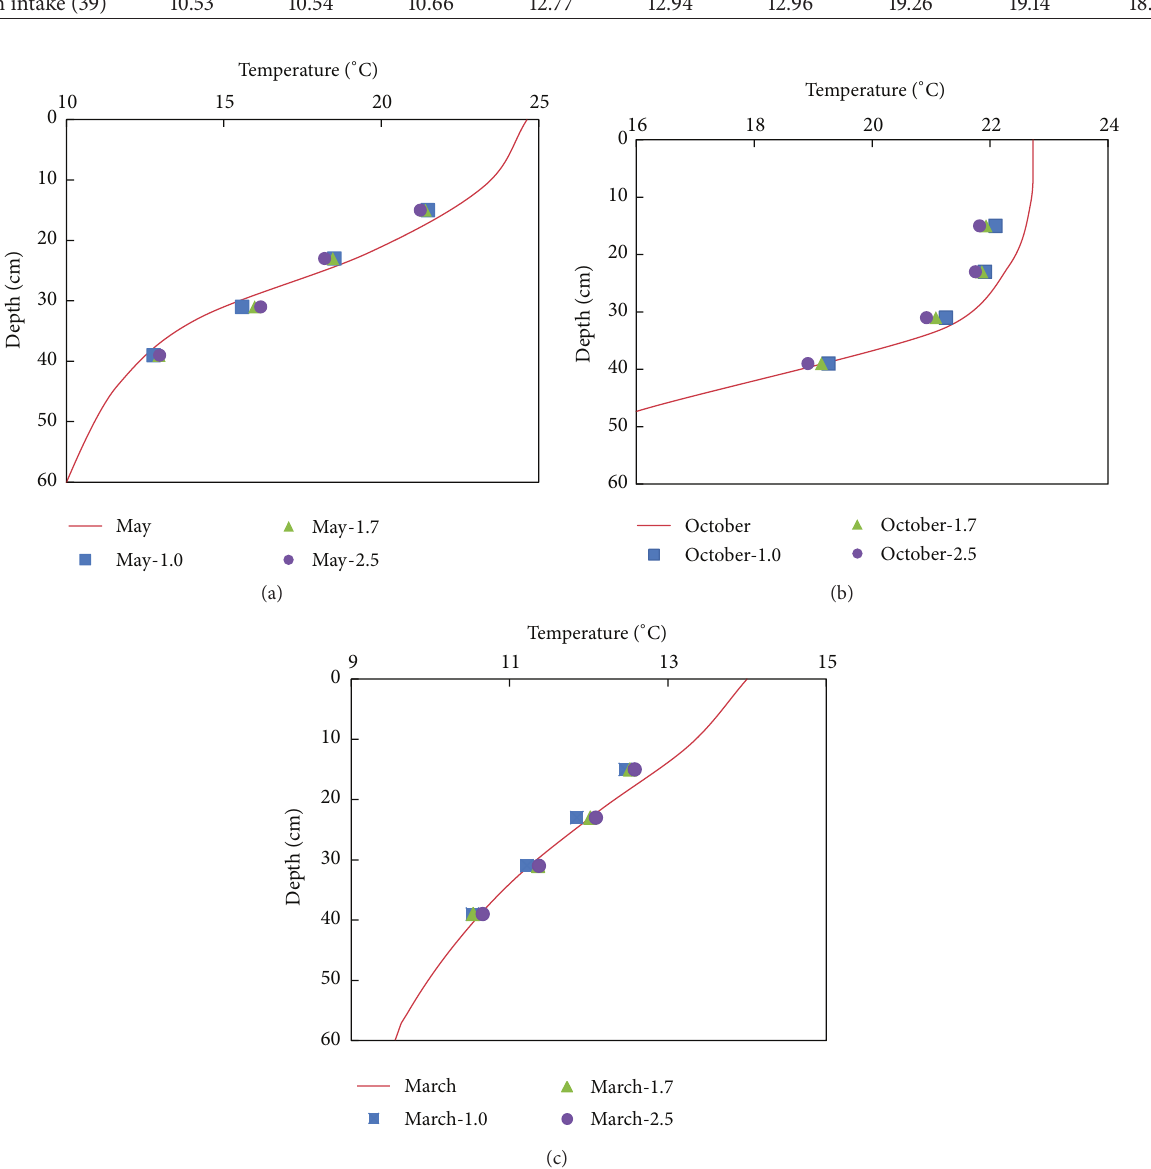
Figure 7: Comparison between the withdrawn water temperature and temperature of water at the orifice center in each month ((a)–(c)).